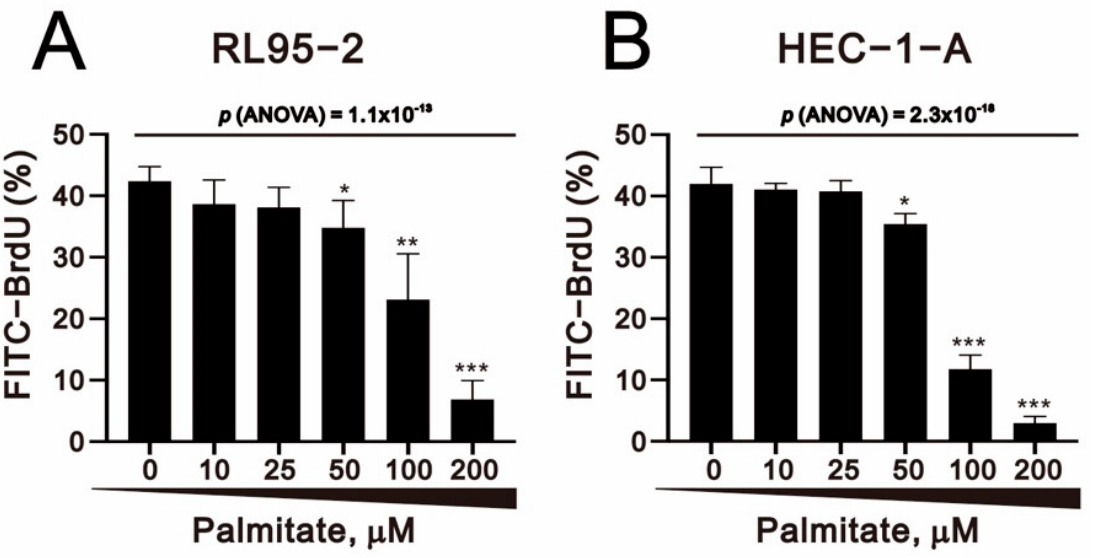
Figure 5. Effect of palmitate on proliferation of human endometrial cancer cells. ( A ) RL95-2 and ( B ) HEC-1-A cells were incubated for 24 h, after which they were treated for 24 or 48 h with the indicated concentrations of palmitate. Cell prolif- eration indicated by BrdU incorporation was analyzed using flow cytometry. Bars depict the mean ± SD of three inde- pendent experiments. * p < 0.05, ** p < 0.01, and *** p < 0.001 (Student’s t -tests).